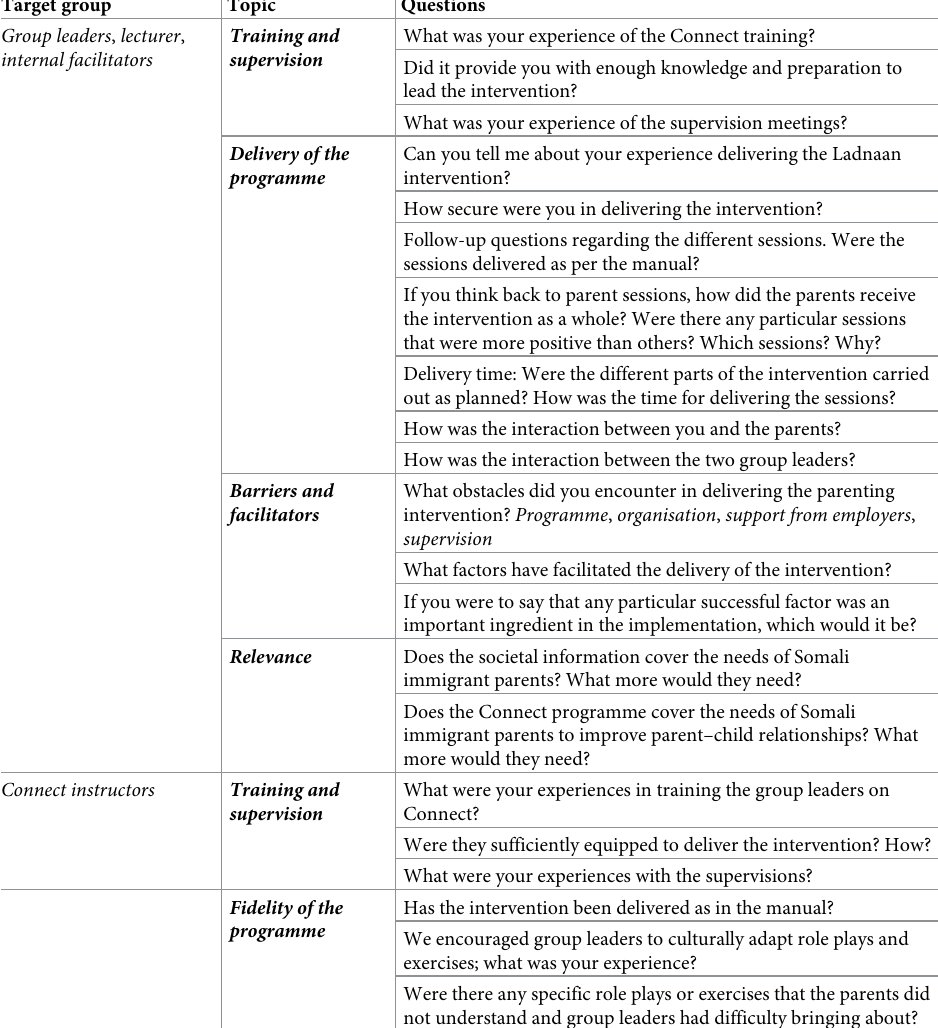
Table 4. Topic guide for focus group discussions for group leaders, internal facilitators and Connect